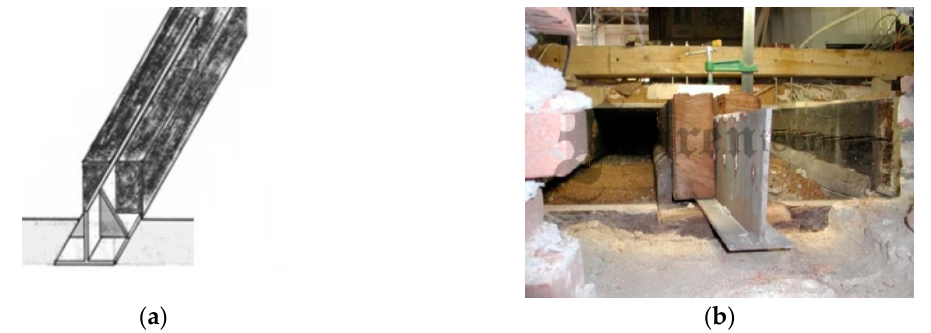
Figure 12. A stainless steel flitch plate inserted into a timber beam and bolted side-to-side: detail of the steel profile used at the beam ends [44,45].